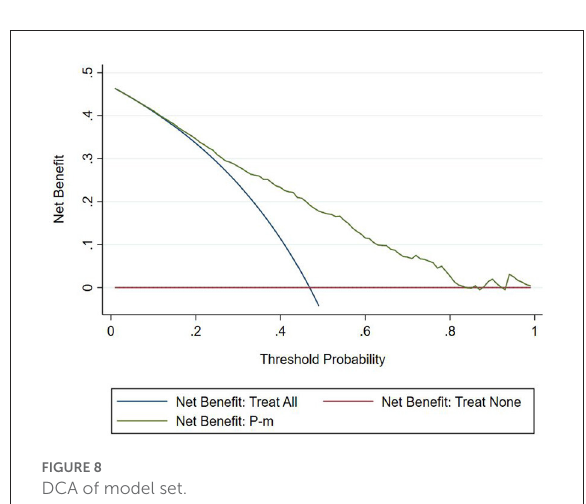
FIGURE8 DCA of model set.